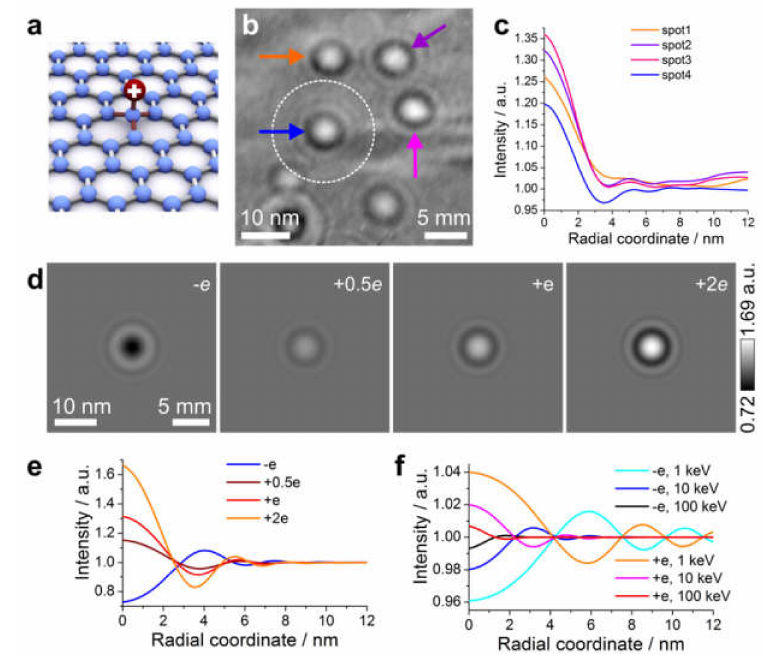
Figure 22. In-line electron holograms of charged adsorbates. ( a ) Schematic representation of a charged adsorbate on graphene. ( b ) Experimental hologram exhibiting bright spots; here, the electron energy is 30 eV, the source-to-sample distance is 82 nm and the source-to-screen distance is 47 mm. ( c ) Angular-averaged intensity profiles of the four bright spots marked in ( b ). ( d ) Simulated in-line holograms of a point charge, at four di ff erent values of charge, where the simulation parameters match those of the experimental hologram shown in ( b ). ( e ) Angular-averaged intensity profiles as a function of the radial coordinate, calculated from the simulated holograms shown in ( d ). ( f ) Angular-averaged intensity profiles as a function of the radial coordinate calculated from the simulated holograms at di ff erent high energies of probing electrons. The scale bars in ( b , d ) indicate the sizes in the object plane (left) and in the detector plane (right). Adapted with permission from [94], Copyright (2016) American Chemical Society.